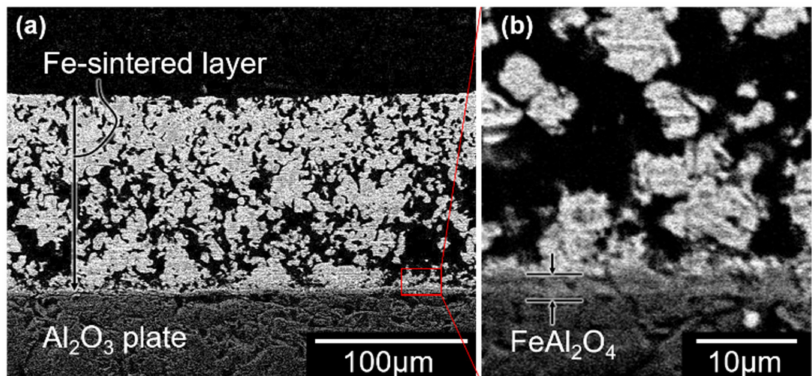
Figure 3. ( a ) Cross-section of the powder-based surface fine crevice structure of metallic iron created on the Al 2 O 3 plate by sintering of Fe 2 O 3 powder under reducing conditions; ( b ) Magnified image of the region of interface between Fe-sintered layer and Al 2 O 3